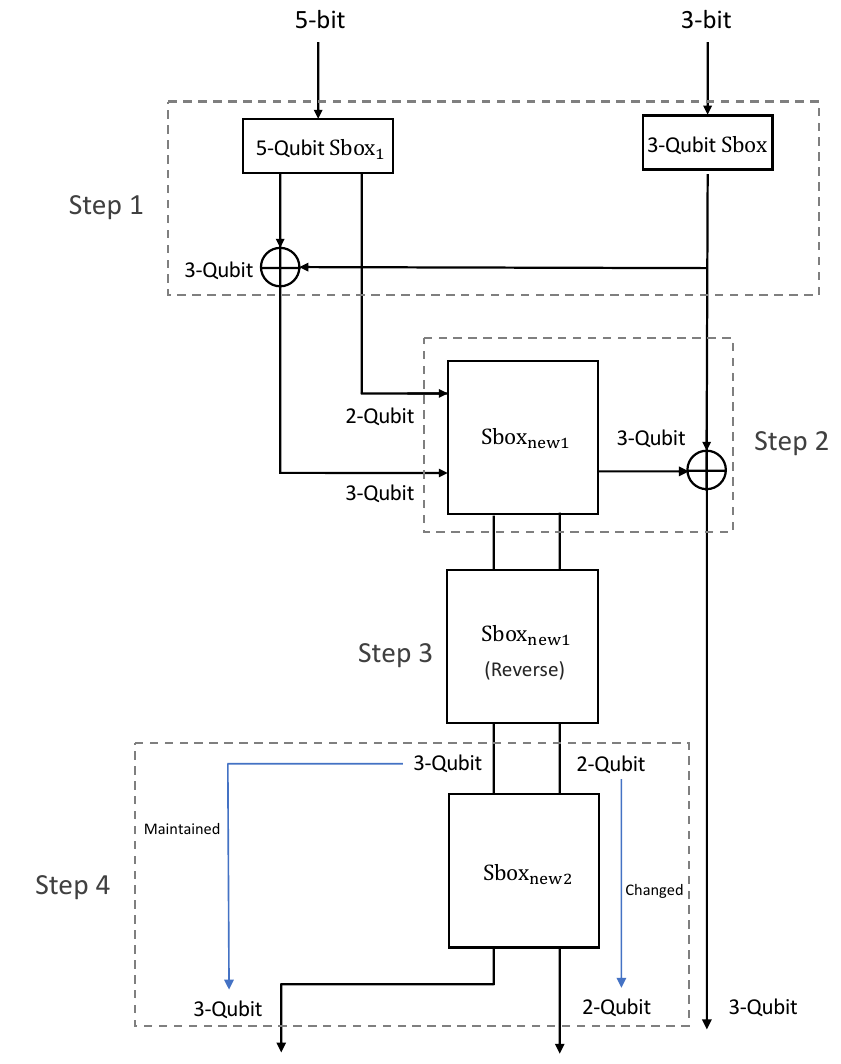
Figure 10. PIPO Sbox in quantum